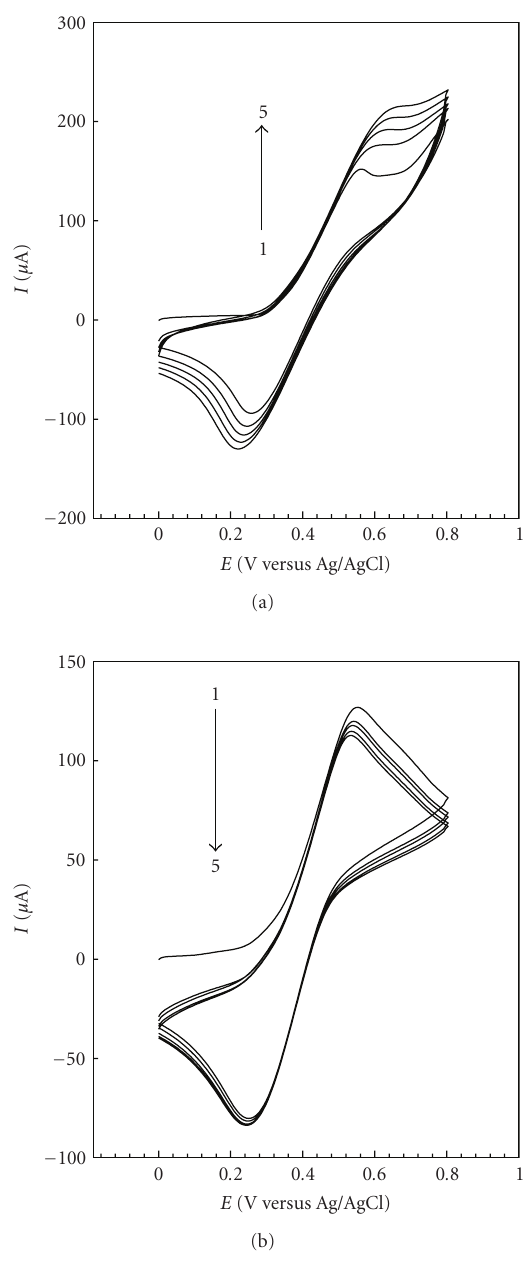
Figure 1: Consecutive cyclic voltammograms of (a) 0.02 M pyrrole and 0.02 M HQSA during electropolymerization process and (b) 0.02 M